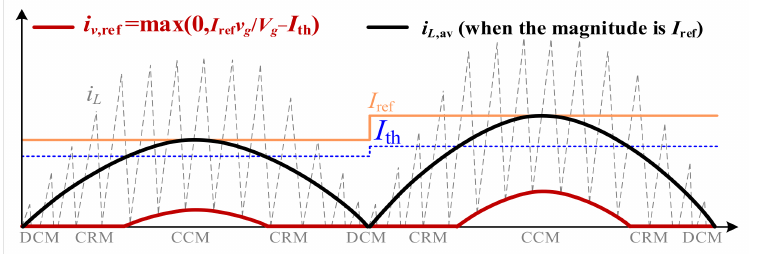
Figure 6. Mixed DCM/CRM/CCM operation with TACC